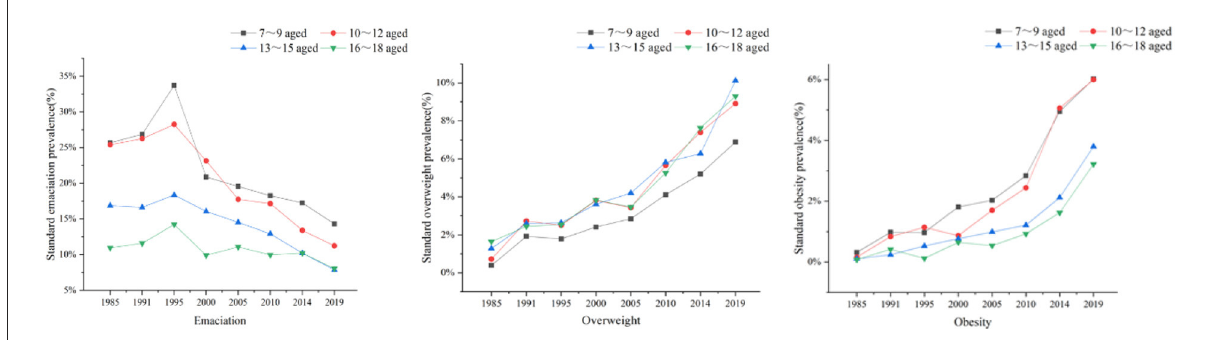
FIGURE3 Gender-standardized prevalence of emaciation, overweight, and obesity among school-aged children of different ages from 1985 to 2019.